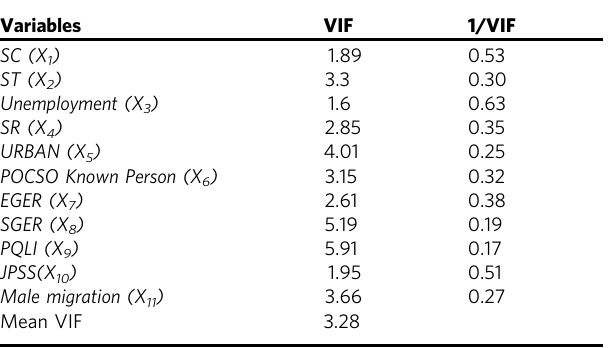
Table 8 Variance in fl ation factor (VIF) for the